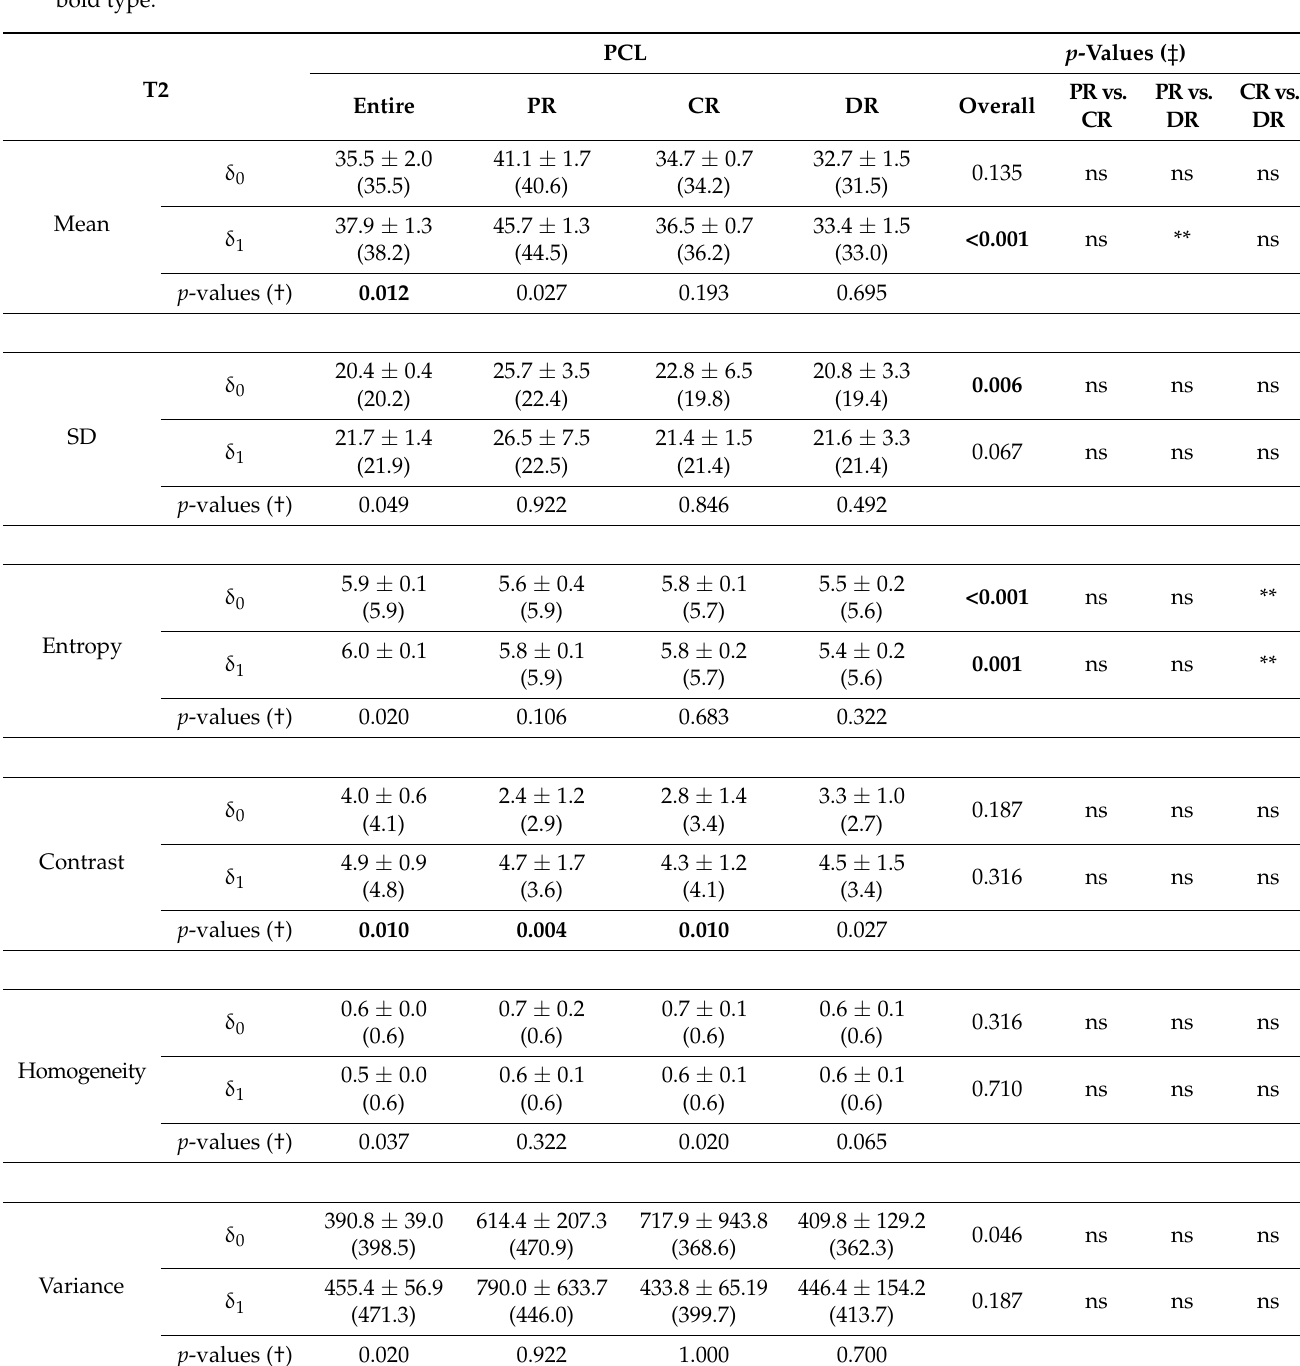
Table 2. Non-parametrical summary statistics and texture variables of T2 maps of the posterior cruciate ligament (PCL) and its subregions as a function of loading ( δ 0 , δ 1 ). Mean T2 relaxation times and standard deviations (SD) as well as texture variables, i.e., entropy, contrast, homogeneity, and variance, were determined for the entire PCL, the proximal subregion (PR), the central subregion (CR), and the distal subregion (DR). Unloaded ( δ 0 ) and loaded ( δ 1 ) configurations. Mean ± standard deviation. Median values are indicated in parentheses. For each region-of-interest and T2 parameter, δ 0 and δ 1 were compared using the Wilcoxon signed rank test and the respective p -values are displayed in columns (†). For each configuration and T2 parameter, the subregions were compared using the Friedman test followed by Dunn’s multiple comparison test. The respective p -values are displayed in rows (‡). Significant differences are indicated by ** or displayed in bold type.